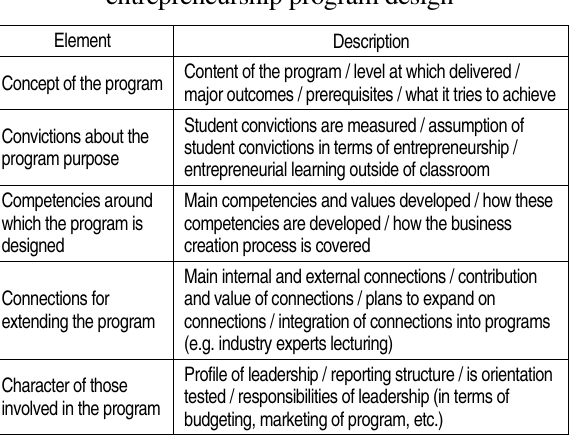
Table 3. 5C’s framework for 21st